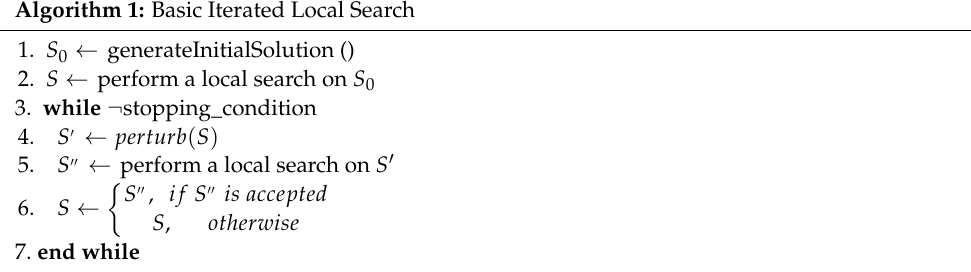
Algorithm 1: Basic Iterated Local